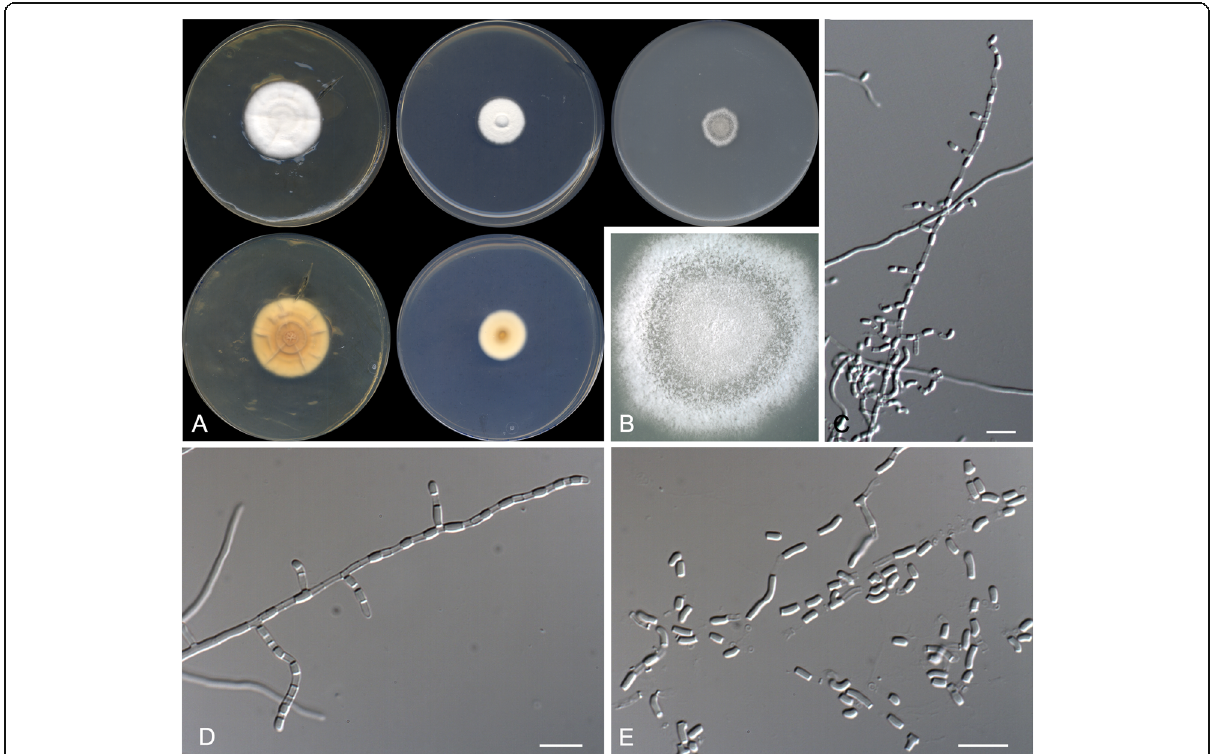
Fig. 8 Malbranchea stricta CBS 146932 T . a Colonies on PYE, PDA and OA after 14 d at 25 °C, from left to right (top row, surface; bottom row, reverse). b Detail of the colony on OA. c – e Alternate arthroconidia on primary hyphae and lateral branches. Scale bar = 10 μ